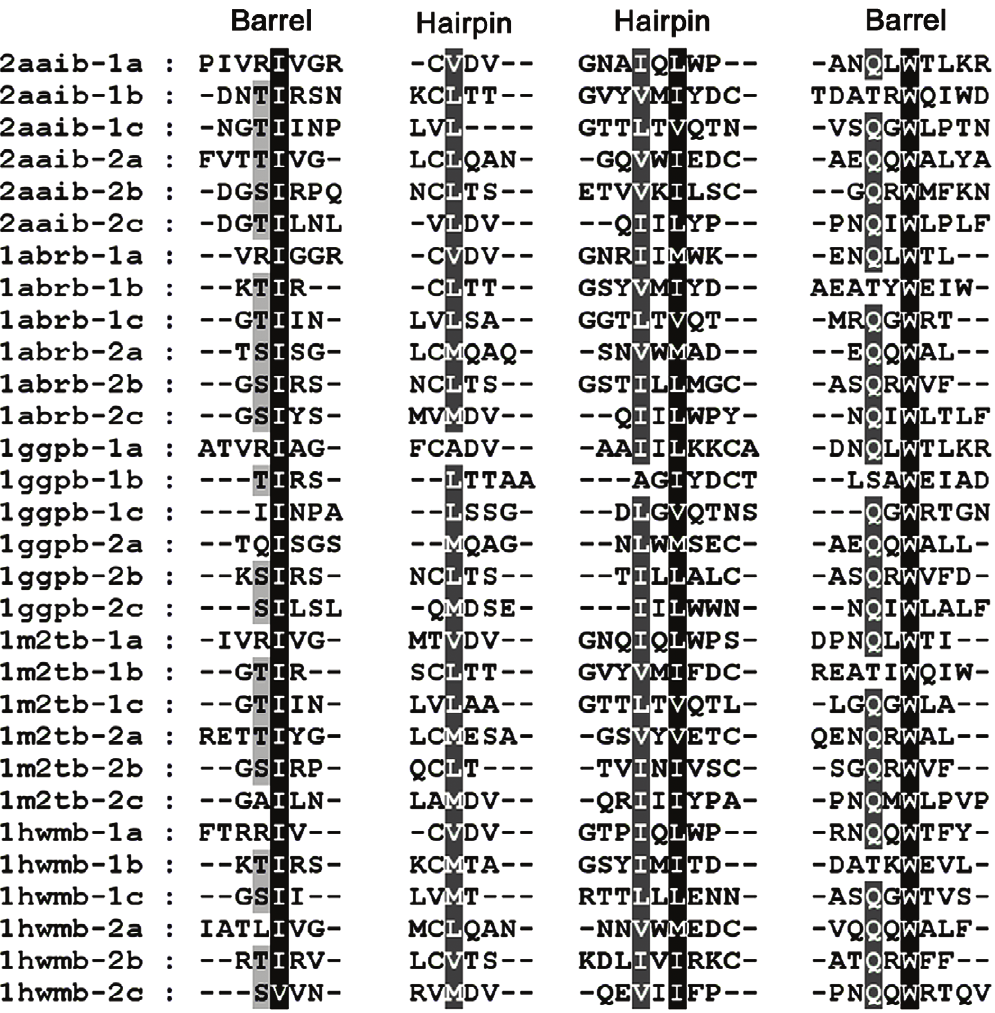
Figure 2. Structure based multiple sequence alignments of trefoil units in two domains of five representative protein chains. Conserved residues and most conserved residues are shaded gray and black respectively.